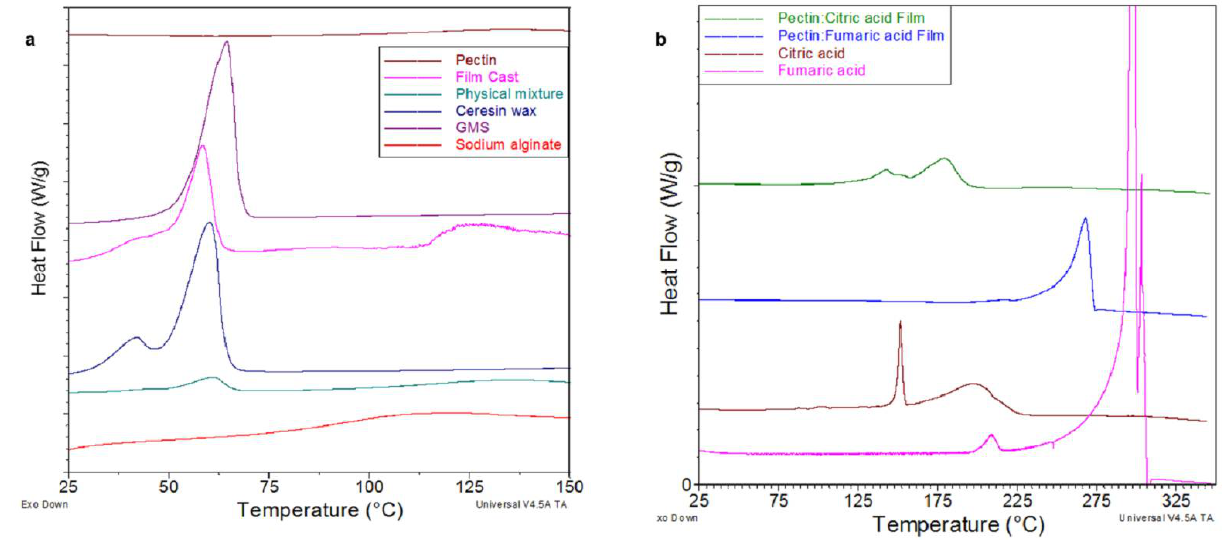
Figure 3. TGA thermographs of ( a ) single components of coating system, physical mixture, and casted film (F2); ( b ) organic acids and their casted film.